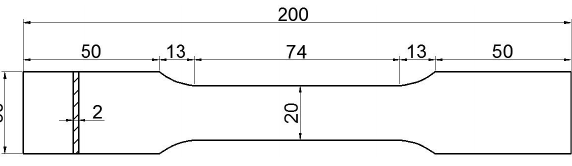
Figure 2: Dimension diagram of testing pieces for material proper-